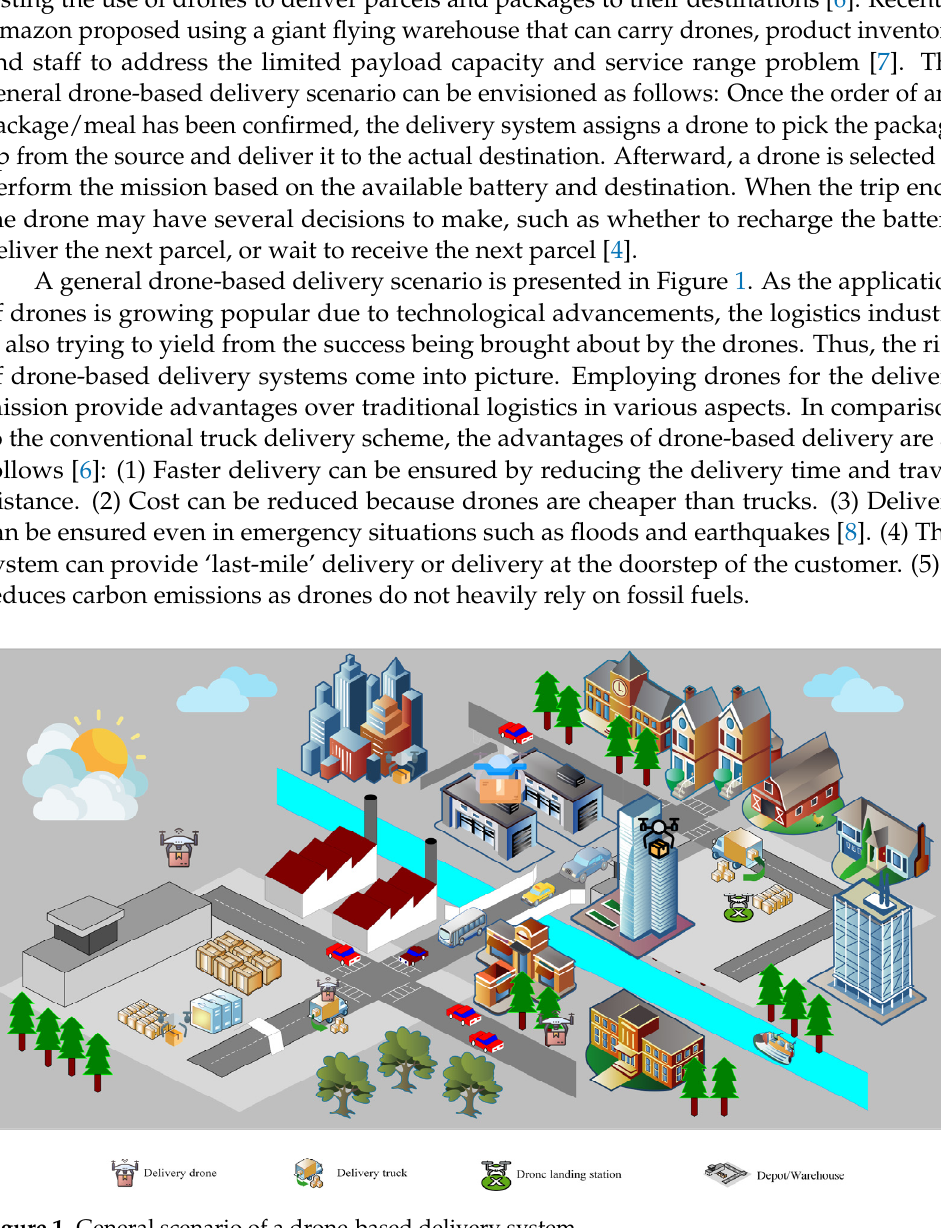
Figure 1. General scenario of a drone-based delivery system.